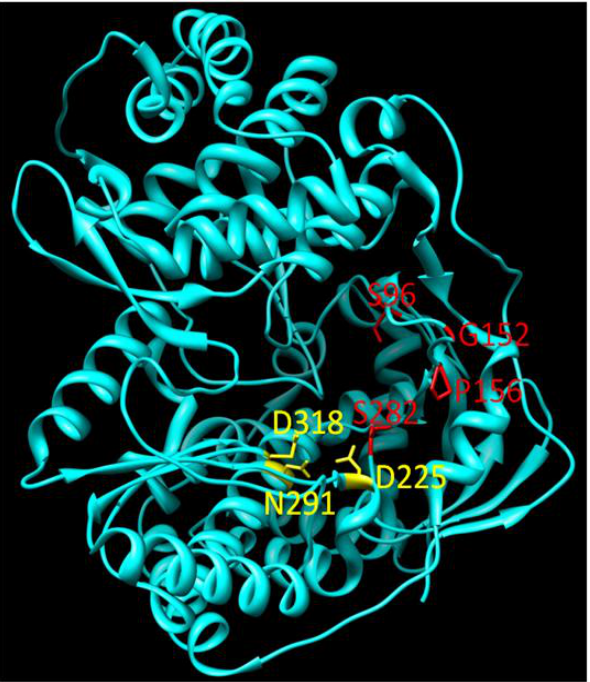
Figure 4. Positioning of mutations conferring resistance to HCV NI and PPi analogue inhibitors. Active site residues are highlighted in yellow and positions for resistance mutations in red. Mutations at the S96 and S282 positions confer resistance to NIs, while substitutions of the amino acids P156 and G152 leads to resistance to PPi